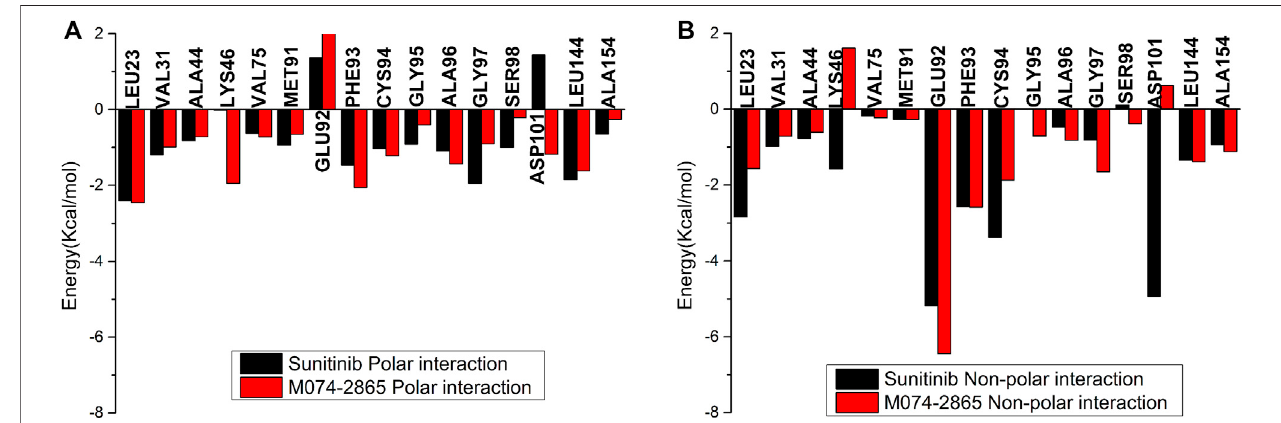
FIGURE 7 | Polar energy contribution (A) and non-polar energy contribution (B) comparison of HPK1 inhibitors binding to key residues.